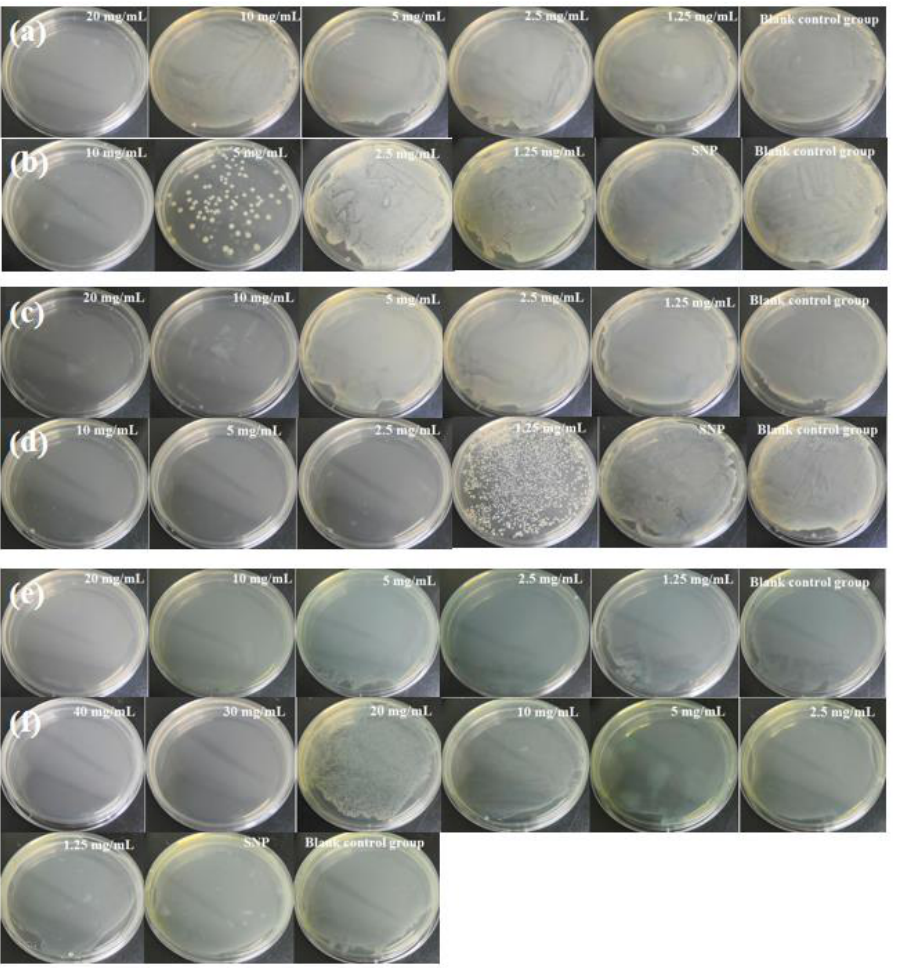
Figure 7. Image of the minimum bactericidal concentration test results of CEO and CEO − SNP against E. coli ( a , b ), S. aureus ( c , d ) and P. aeruginosa ( e , f ), respectively. ( a , c , e ) represents the antibacterial effect of CEO, whereas ( b , d , f ) represents the antibacterial effect of